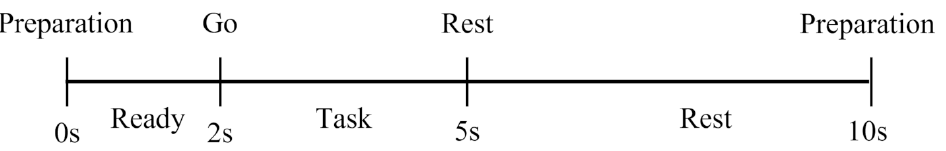
Figure 1. The flow of a single trial. There were 60 trials in